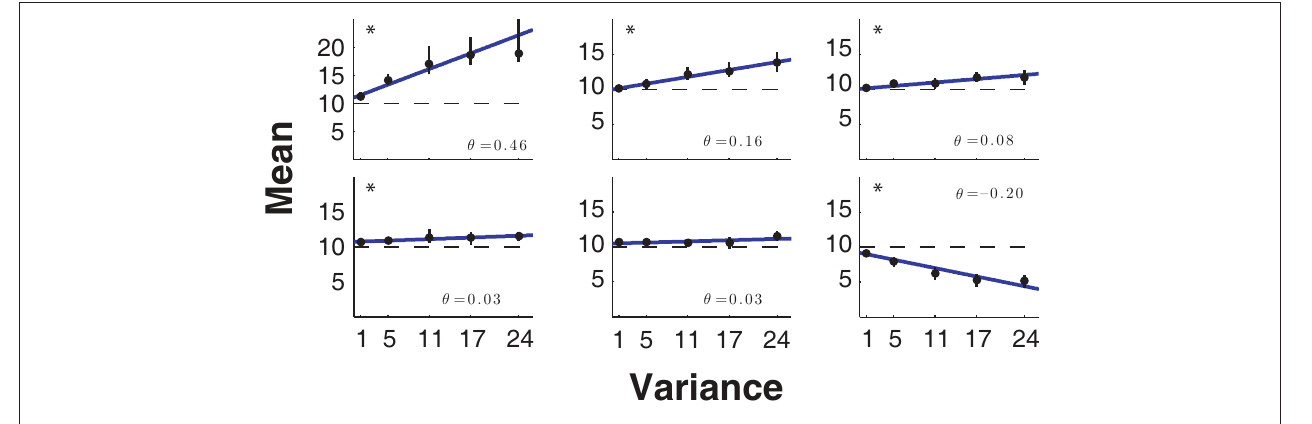
Figure 2 | Mean–variance trade-off. Six representative subjects of the mean–variance trade-off experiment (Nagengast et al., 2010b) ordered from the most risk-seeking to the most risk-averse. The five indifference points ± SD obtained using psychometric curve fits are shown in black. The best lines of fit were obtained using weighted linear regression